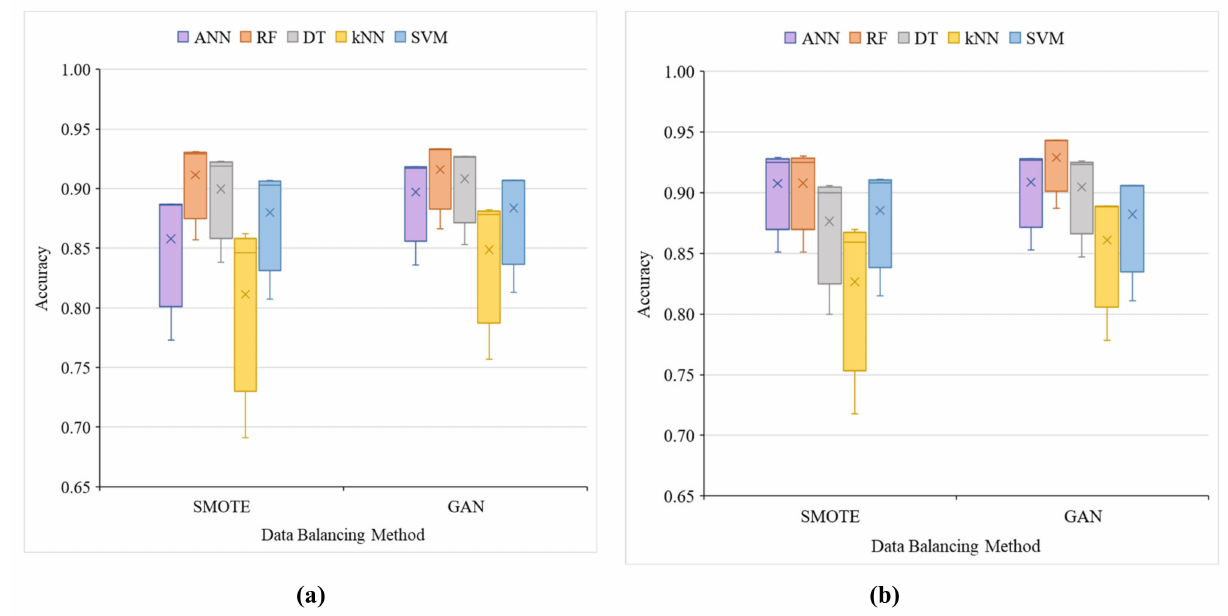
Figure 5. Assessment of SMOTE and GAN data balancing methods using different machine learning models. The accuracy refers to the total combination of four multi-metrics including OA, Kappa Index, F1-score, and AUROC. ( a ) Default parameters, and ( b ) optimal